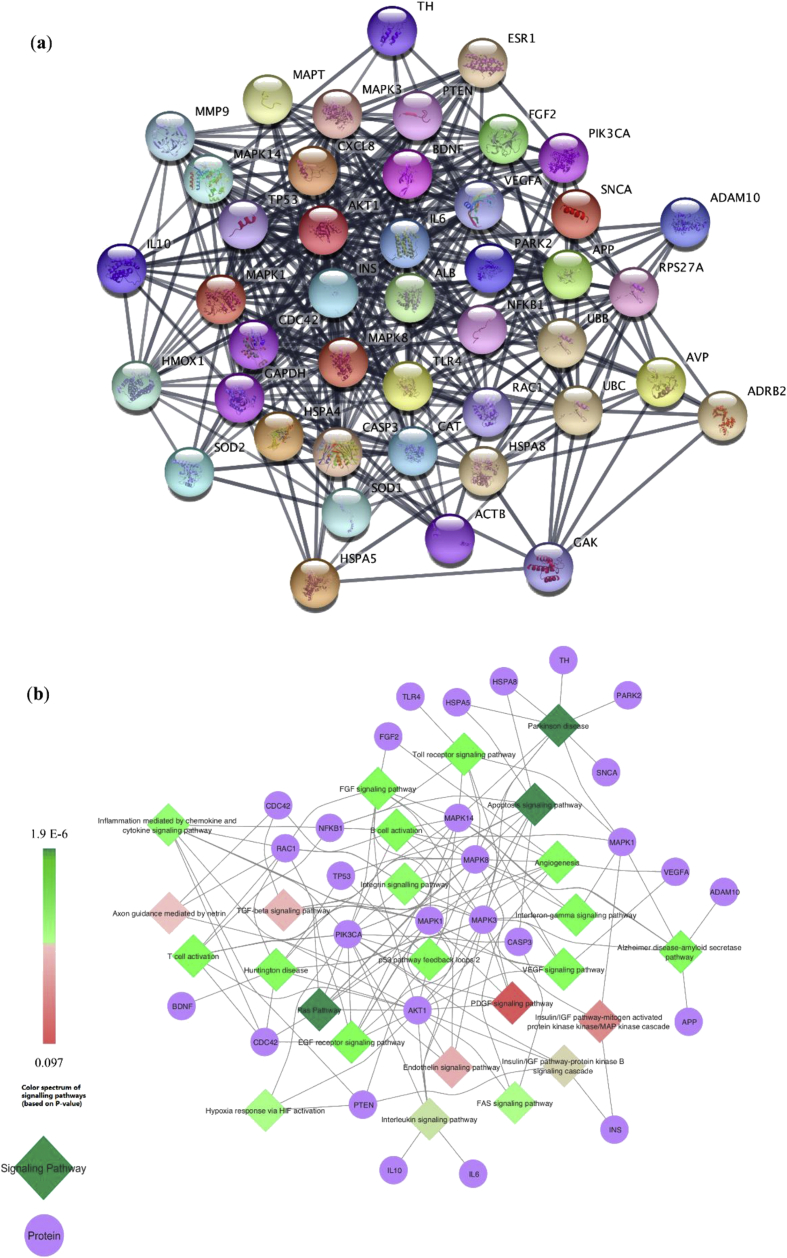
(a) The key proteins related to the PPI-PD network obtained as common proteins with the highest score through five ranking methods. (b) PANTHER pathway of the key proteins represents the signaling pathways associated with these proteins. The circle and the rhombus indicate the proteins and the signaling pathways, respectively. The color spectrum of signaling pathways varies from red (>0.05) to green (≤0.05) based on P-value.